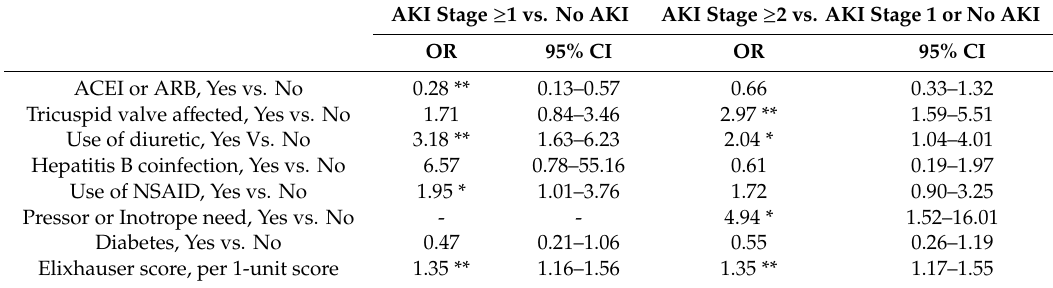
Table 2. Multivariable logistic regression models of AKI stage ≥ 1 and AKI stage ≥ 2 as the dependent variables and relevant clinical parameters as the independent variables.